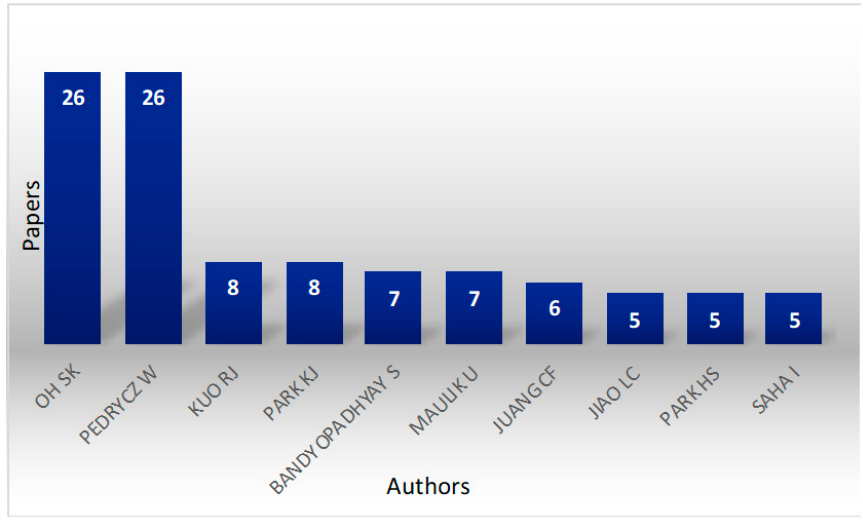
Figure 8. Record by authors for the topic: Optimization fuzzy clustering with genetic algo- rithms.